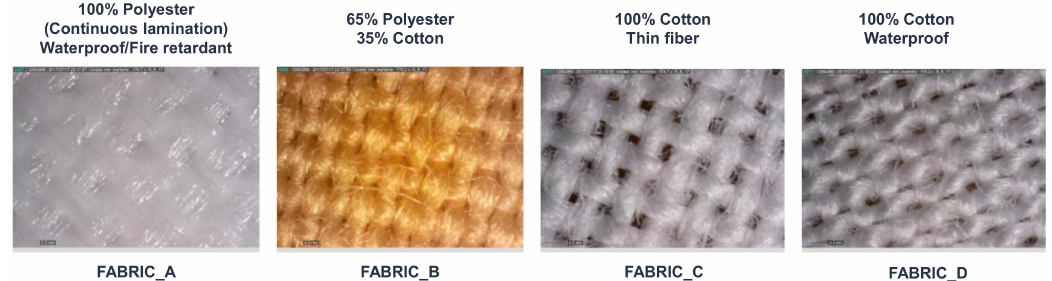
Figure 2. Different types of fabrics used as